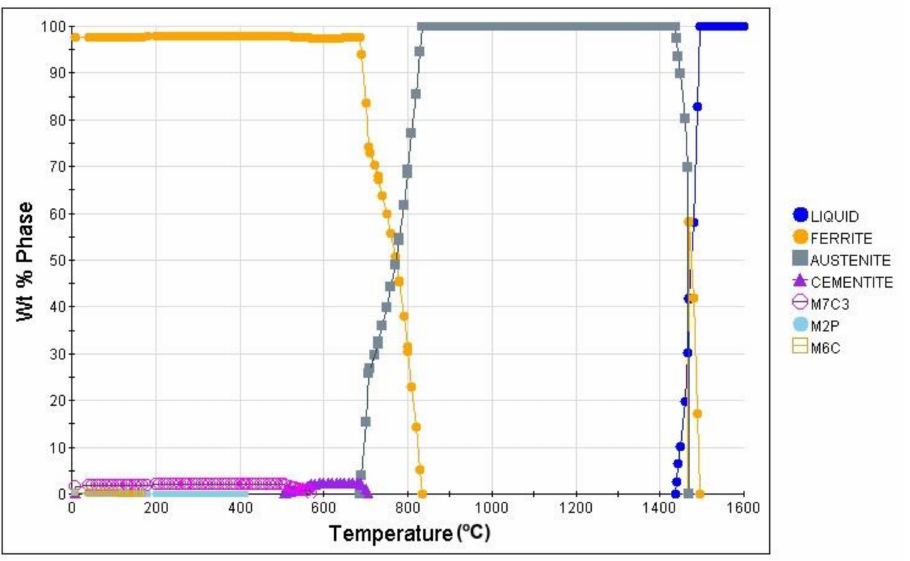
Figure 1. The phase evolution in steel under equilibrium